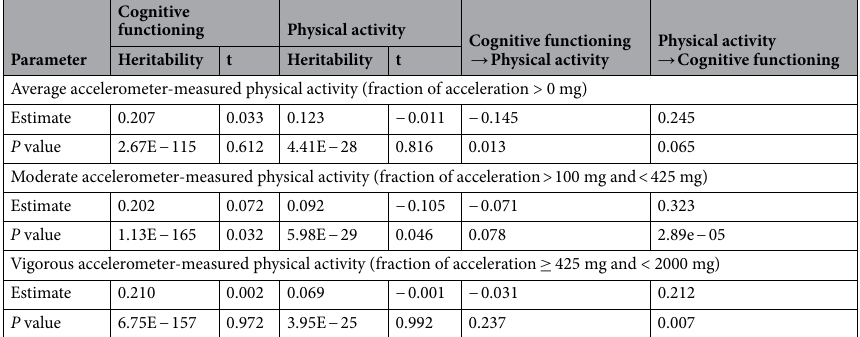
effect (b = − 0.145, CI 95%. = [− 0.26,− 0.03], P = 0.013 [α = 0.008]). Similarly, standard MR methods such as IVW, MR Egger, weighted median, simple mode, and weighted mode yielded non-significant causal estimates in either direction (Table 2), using 129 genome-wide significant single nucleotide polymorphisms (SNPs) as instruments for cognitive functioning and 6 SNPs for average acceleration.